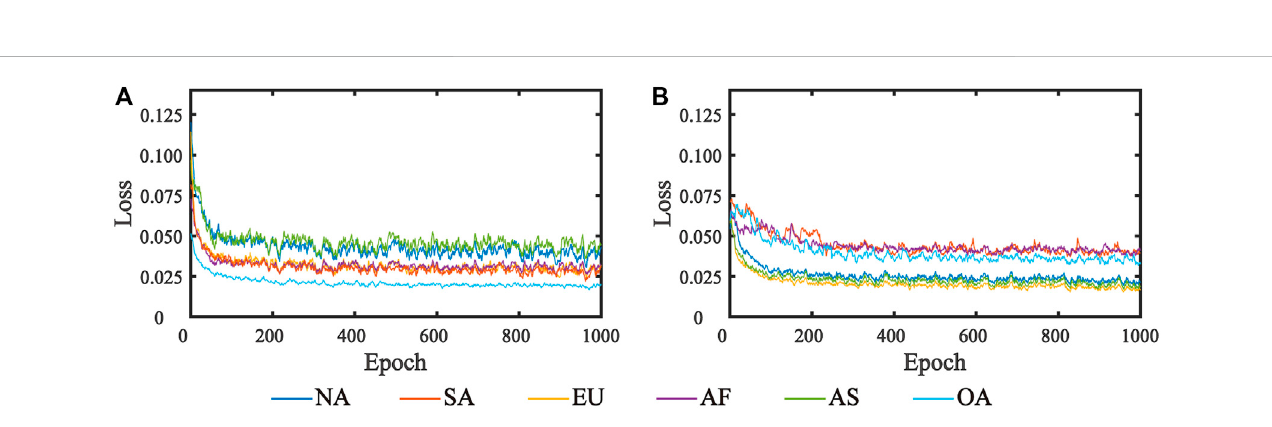
FIGURE 7 The loss function of RMSE for CCI (A) and CM (B) data. The solid lines with different colors represent the loss functions of different regions, which are consistent with each partition in Figure 2. Each epoch includes 366